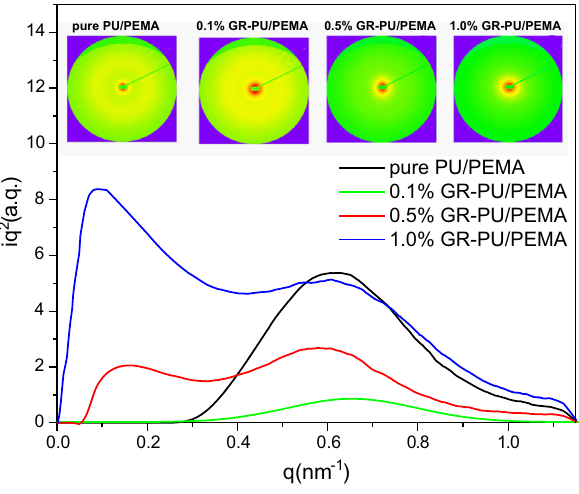
Figure 6: SAXS scattering patterns and Lorentz - corrected curves of 1.0 wt% GR - PU/PEMA.